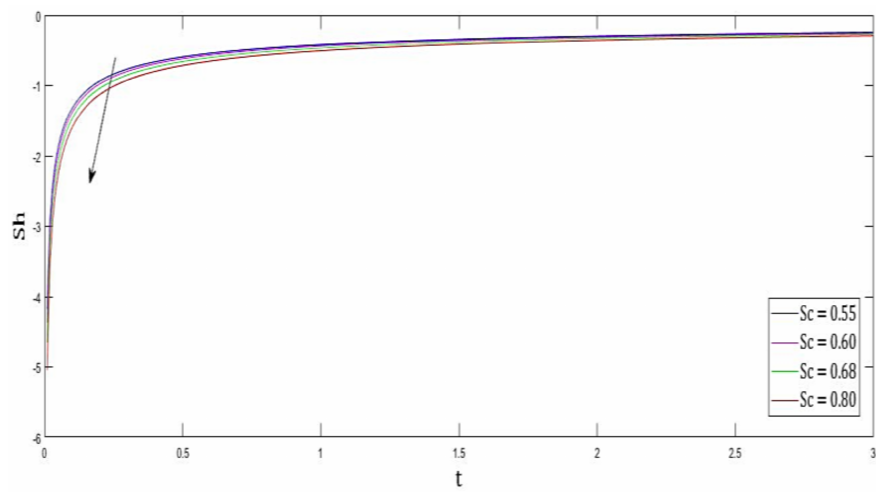
Figure 13. Variation in Sherwood number with respect to Schmidt number.